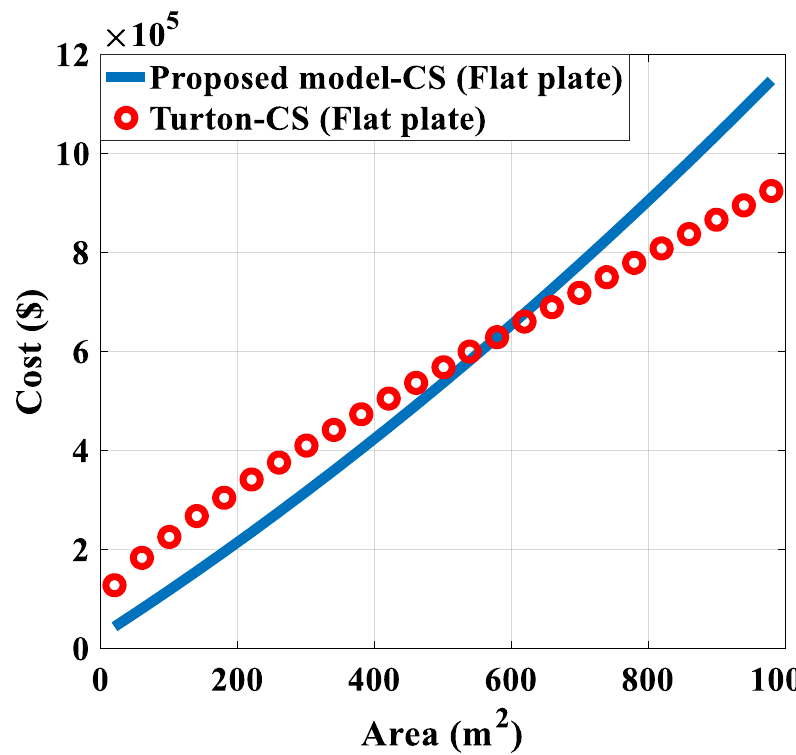
Figure 12. Flat plate heat exchanger cost against area [28]. Table 6. The coefficients of Equation (3) for heat